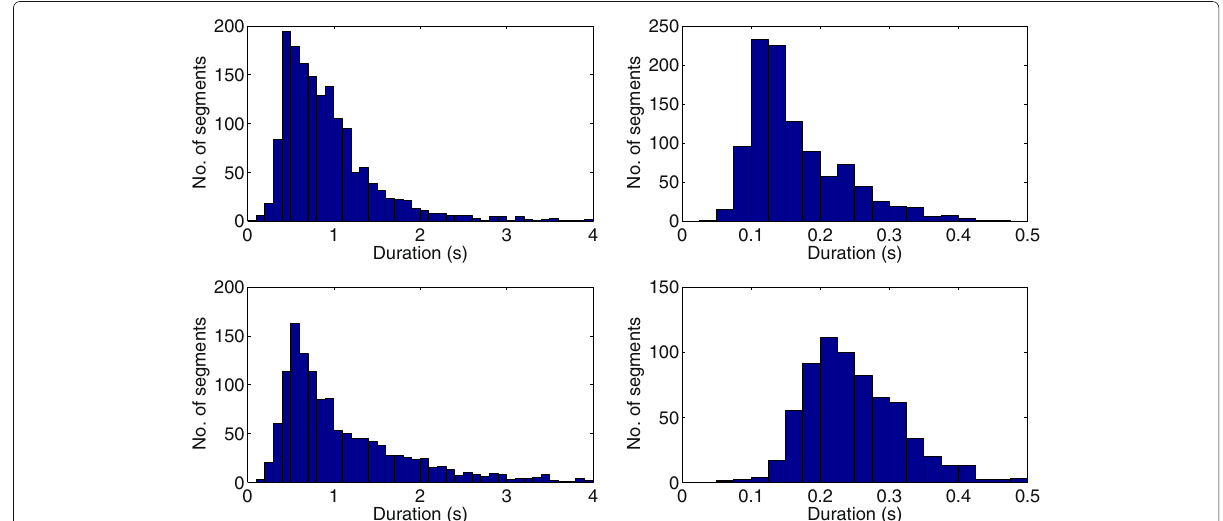
Fig. 9 Distribution of durations of expiratory (left) and inspiratory (right) phases for Tampere (top) and Cape Town (bottom) cohorts